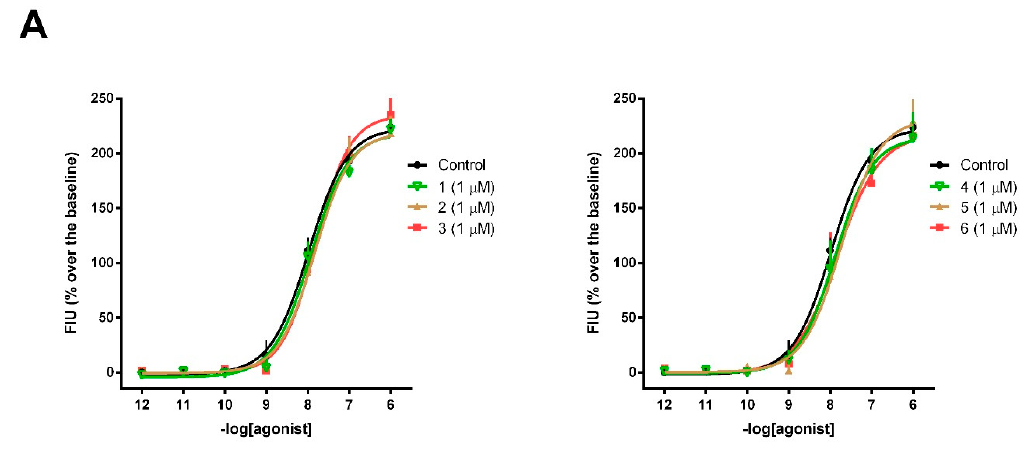
Figure 2. Cont Figure 2. Cont.